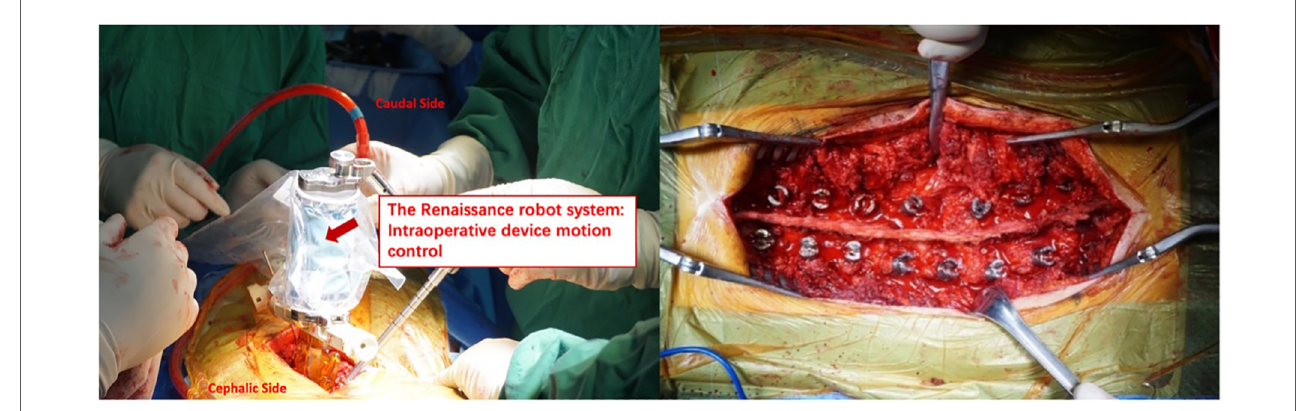
FIGURE 2 The controllable device of Renaissance robot system moves to planned screw trajectory position and direction on the basis of preoperative CT image, then pedicle screws were inserted according to the settled trajectory as drilled